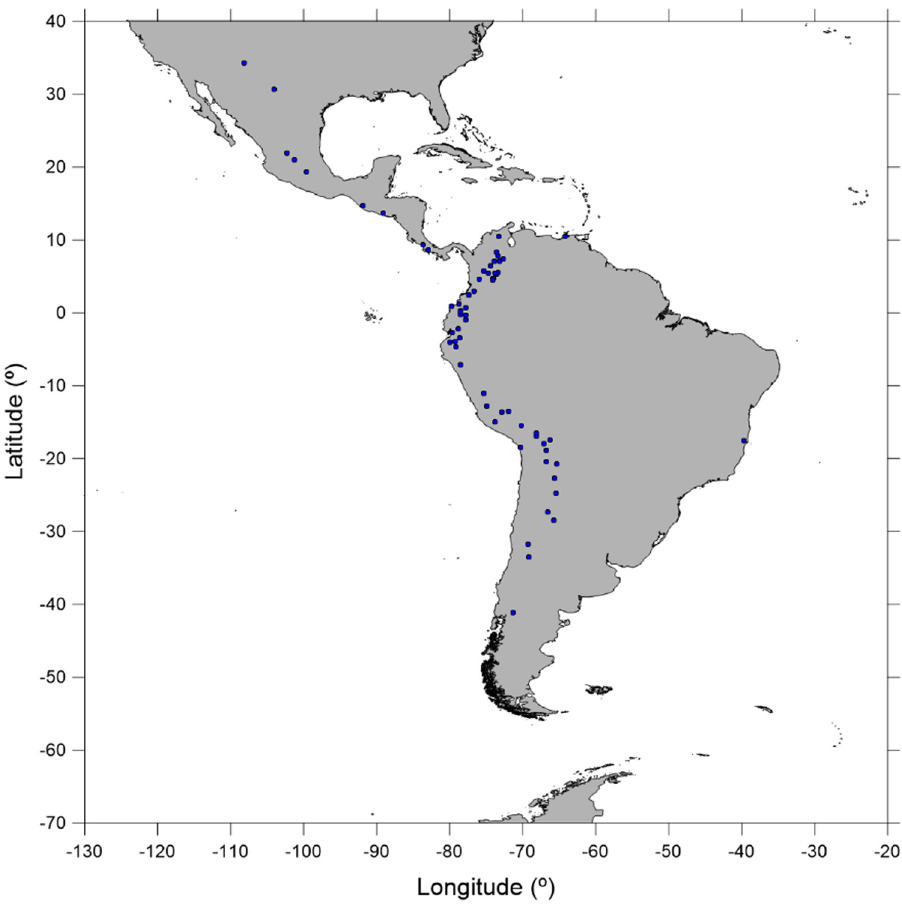
Figure 3: 107 stations located in zones where the NWM may not fi t the relief variations well due to its